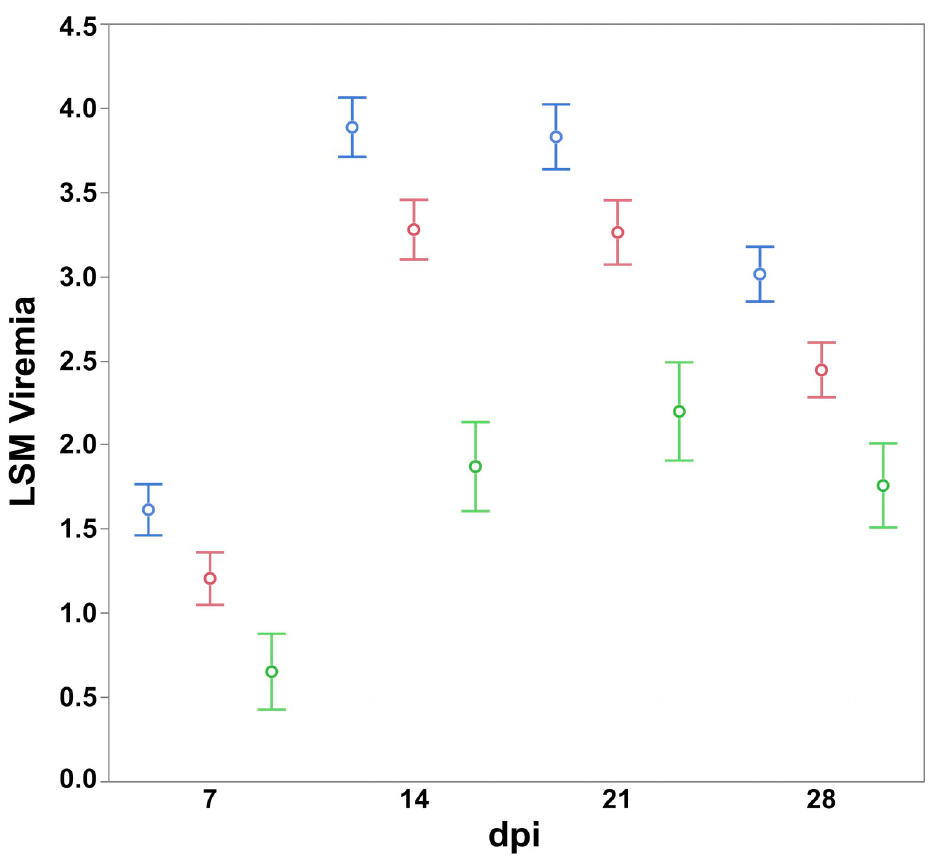
Fig 6. Least square means and standard errors of the SYNGR2 p . Arg63Cys genotypes ( 63Cys /63Cys —green, 63Arg /63Cys— red, 63Arg/63Arg— blue) across weekly viremia measures following PCV2b challenge (n = 268).